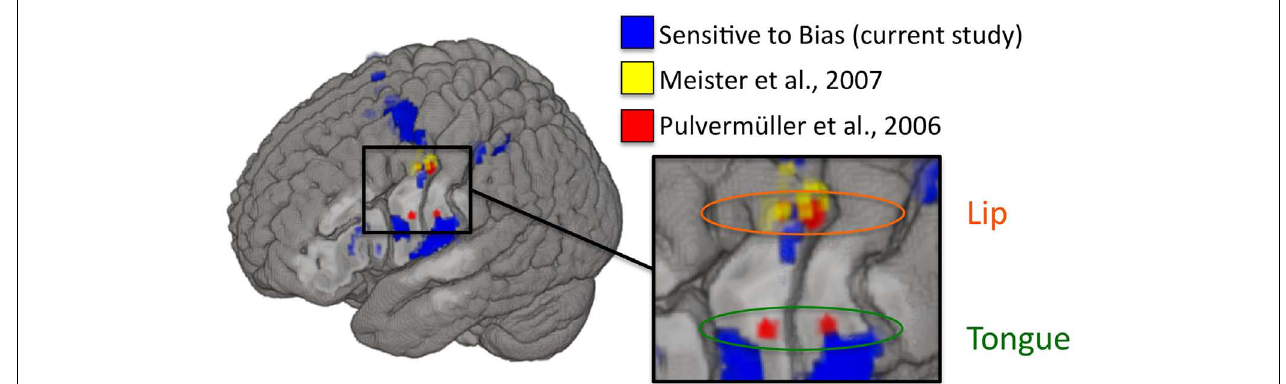
Disruptive stimulation of these targets resulted in a slight decrement in syllable identification performance.The motor ROIs from Pulvermüller et al. were identified on the basis of activation to lip and tongue movements in a motor localizer experiment.The motor somatotopy established therein is also shown (lip foci are circled in orange and tongue foci are circled in green).The two posterior foci (one in the lip region and one in the tongue region) were chosen to targetTMS stimulation in D’Ausilio et al. (2009), which demonstrated that excitatory stimulation to lip and tongue motor cortex selectively facilitated identification of phonemes relying on those